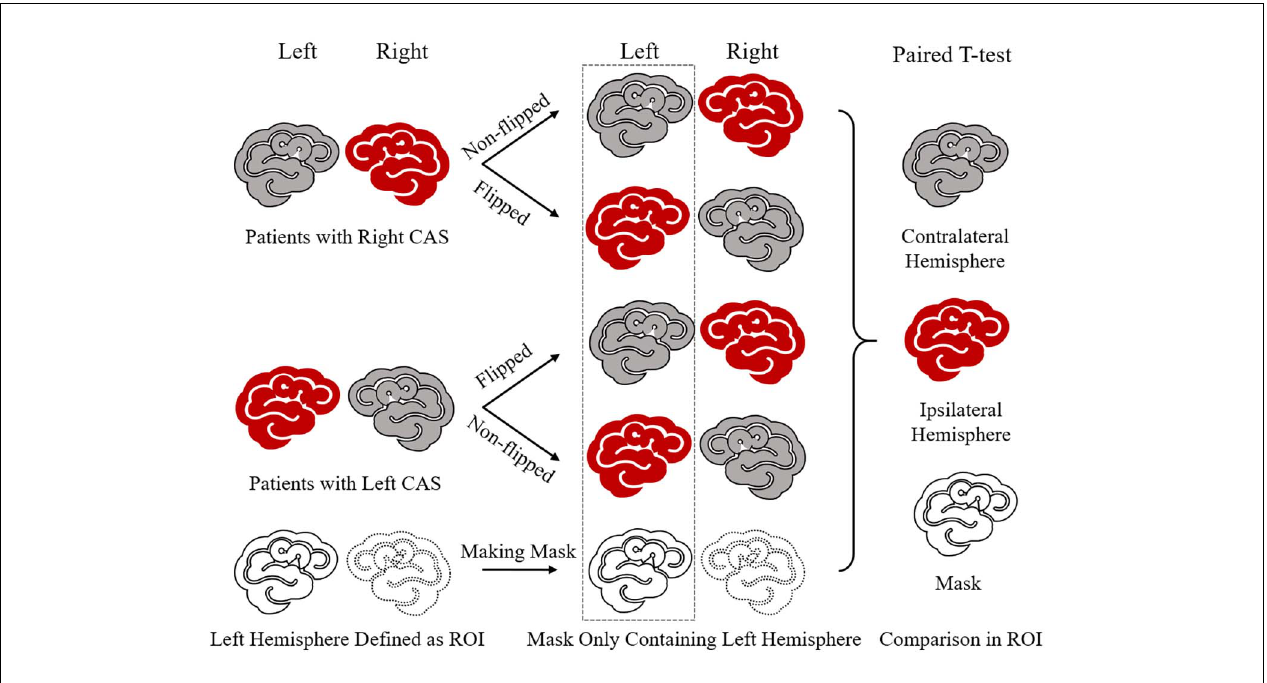
FIGURE 1 | Diagram of stenosis-side hemisphere vs. contralateral hemisphere. First, in each unilateral CAS patient, ipsilateral hemisphere and contralateral hemisphere cannot be paired and compared directly. So, the GM image of each patient needs to be flipped in the right–left orientation and then each patient had one non-flipped image and one paired flipped image. In this way, each patient had a stenosis hemisphere and a contralateral image on the left side when his/her non-flipped image and flipped image were paired together. Thus, patients’ non-flipped images and flipped GM images were analyzed by paired t -test following mode of contralateral hemisphere vs. stenosis-side hemisphere on the left side defined by left-hemisphere